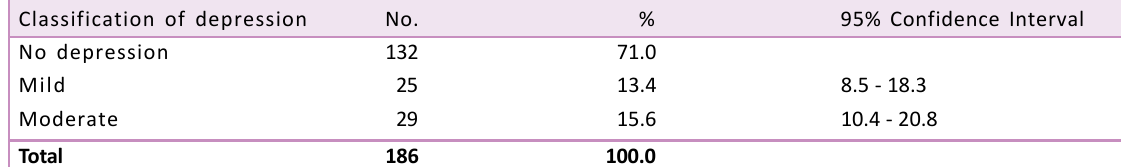
Table 1. Prevalence of depression in patients with type 2 diabetes Classification of